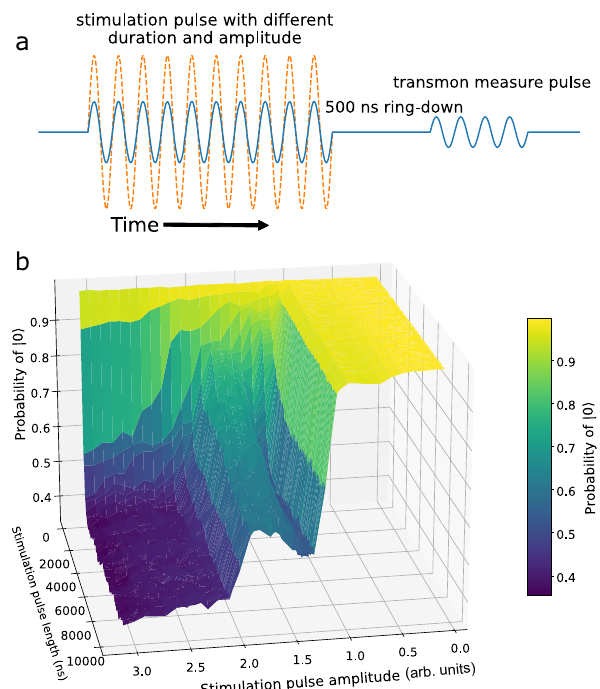
Fig. 4 Qubit excitation by feedline driving. a The pulse sequence used to check the impact of the microwave driving from the feedline on the transmon qubit. We apply a stimulating microwave pulse with a fi xed frequency ω d and different amplitudes and durations. We wait for 500 ns to clear the resonator- fi lter population before performing the qubit dispersive measurement. b Population of 0 j i as a function of the amplitude and duration of the stimulating pulse. Once a critical pulse amplitude is exceeded, the qubit is excited. Our results are qualitatively similar to previous fi ndings 30 . To avoid unwanted excitation, we optimise the driving pulse amplitude and the speed of the protocol. For other linear lossy bosonic mode systems without a dispersively coupled qubit (e.g. optomechanics), STA will not be limited in this